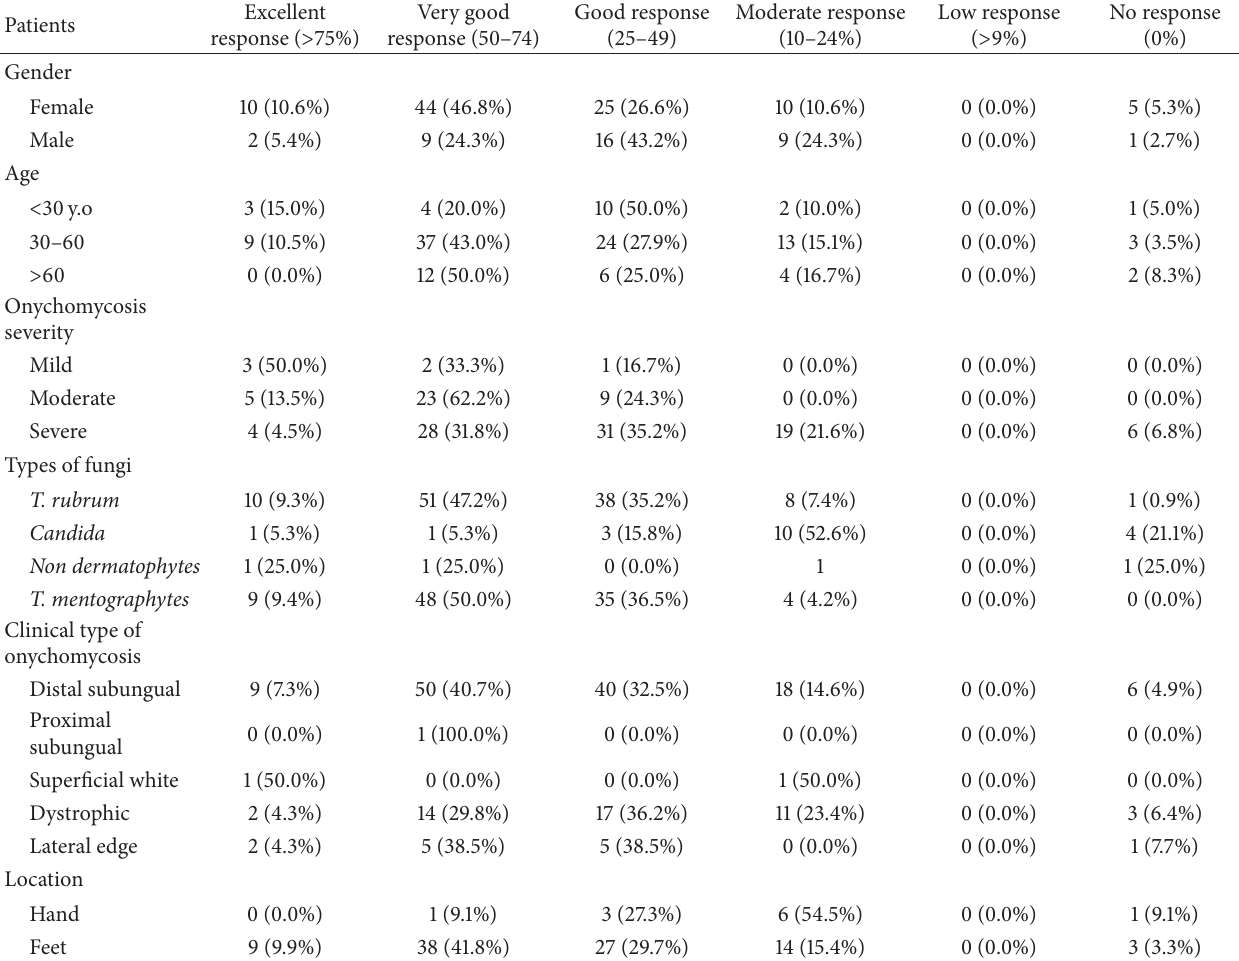
Table 5: Laser treatment response according to age, gender, type of fungi, clinical type of onychomycosis, and location. Patients